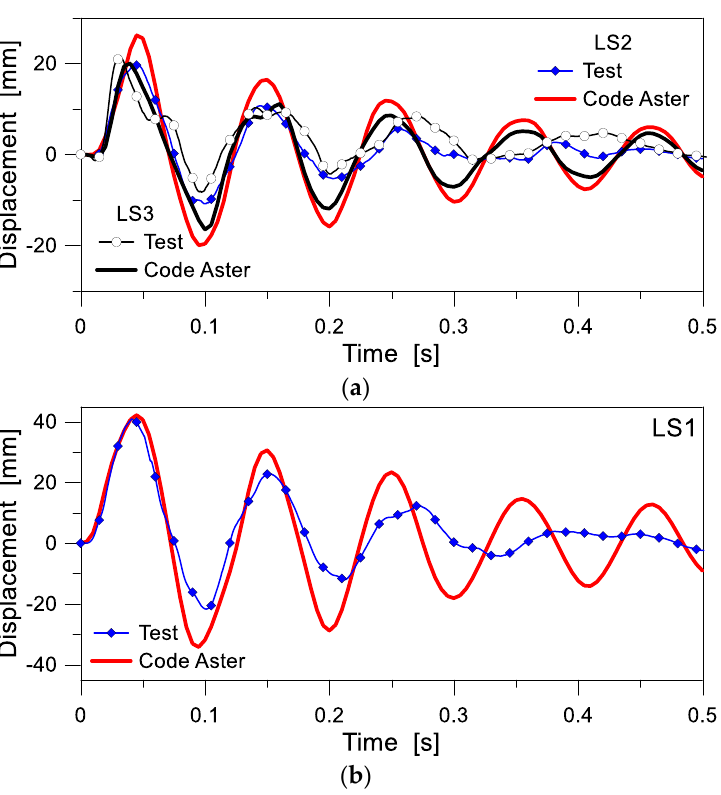
Figure 15. Numerical and experimental out-of-plane displacements for the curtain wall under SB (P#1, E imp = 900 J). In evidence, the control points ( a ) LS1 and ( b ) LS2, LS3.